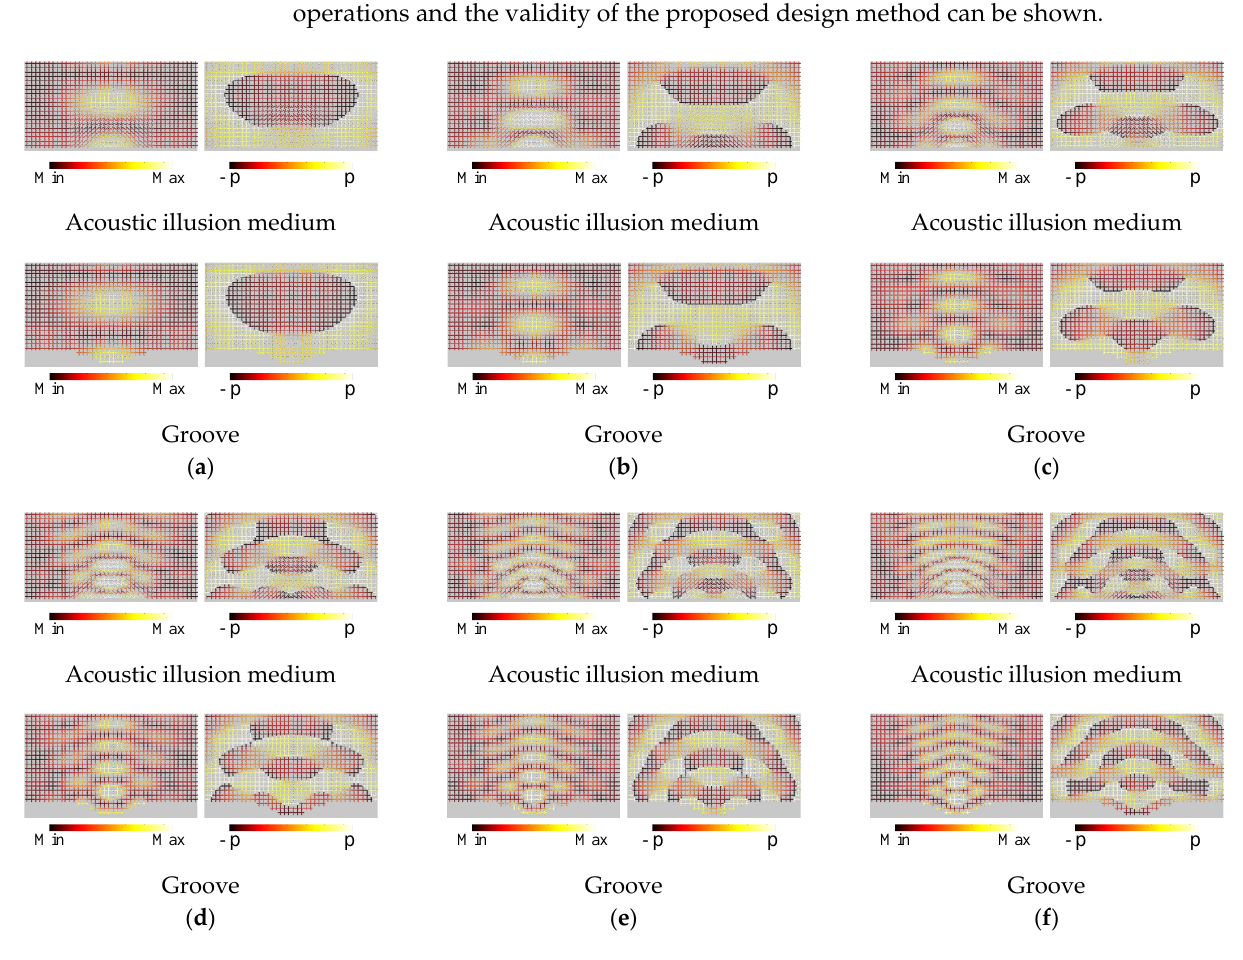
Figure 15. Complex sound pressure distributions for the acoustic illusion medium and the groove. ( a ) 1.0 kHz ( λ /∆ d = 22.3); ( b ) 1.5 kHz ( λ /∆ d = 14.8); ( c ) 2.0 kHz ( λ /∆ d = 11.1); ( d ) 2.5 kHz ( λ /∆ d = 8.91); ( e ) 3.0 kHz ( λ /∆ d = 7.42); ( f ) 3.5 kHz ( λ /∆ d = 6.36). Left: Amplitude. Right: Phase.